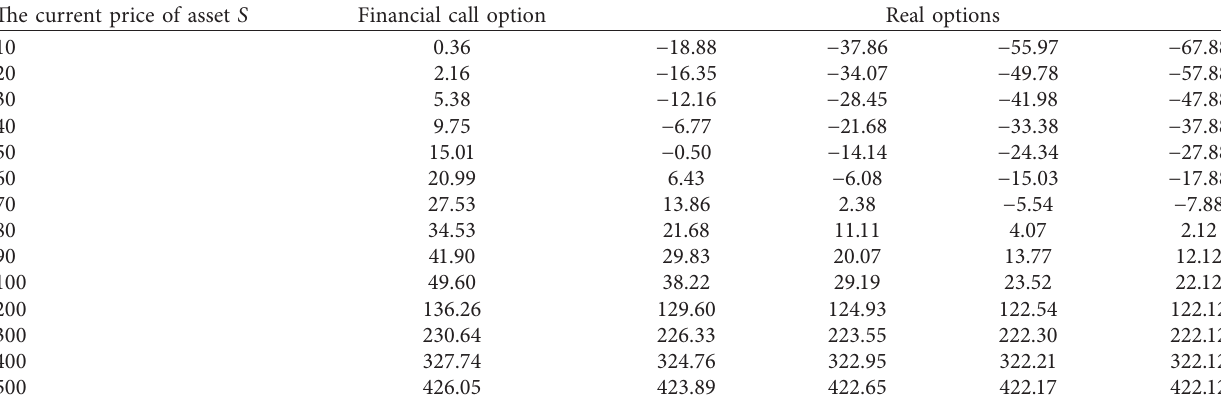
The current price of asset S Financial call